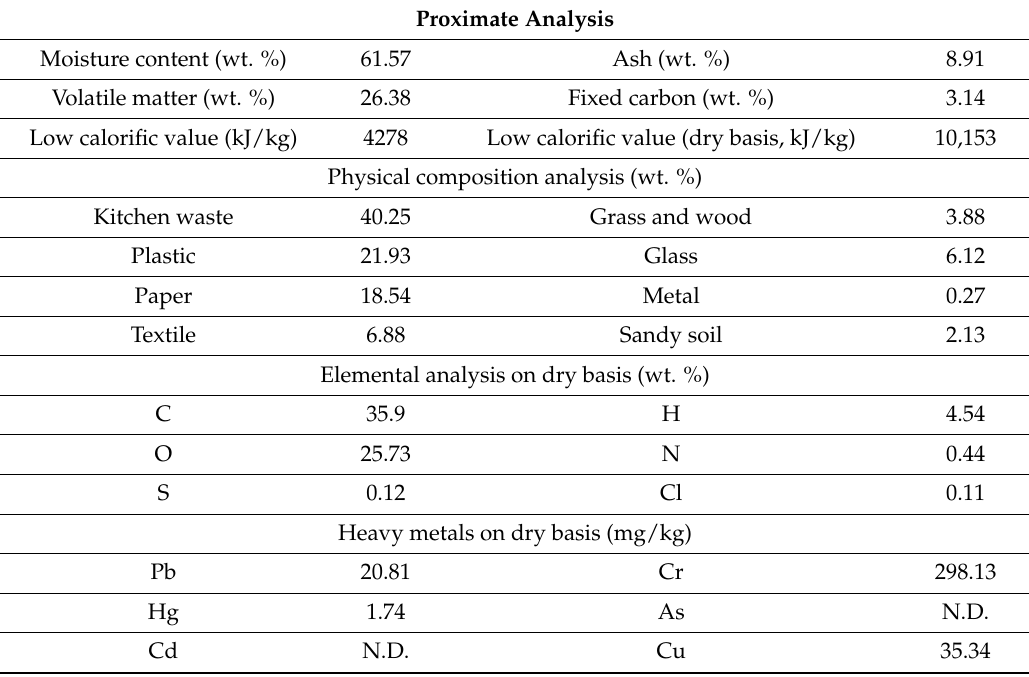
Table 1. Rural solid waste (RSW)